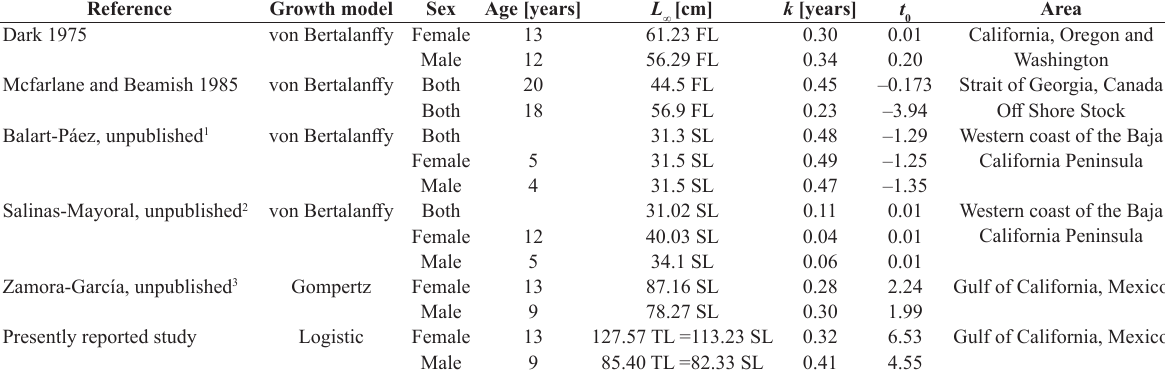
Table 6. Summary of estimates of growth parameters of Pacific hake, Merluccius productus , by various authors.